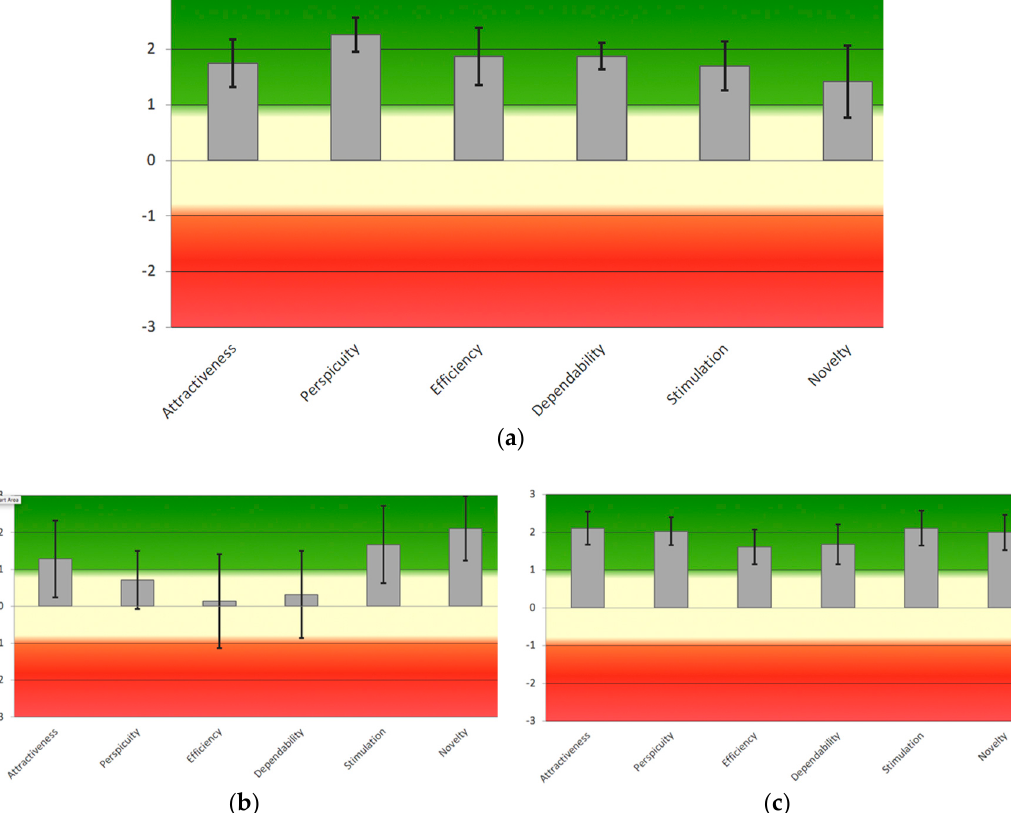
Figure 10. Data analysis results of ( a ) UEQ for MAI; ( b ) UEQ for nAoMI for users 1–7; ( c ) UEQ for nAoMI for users 8–16.